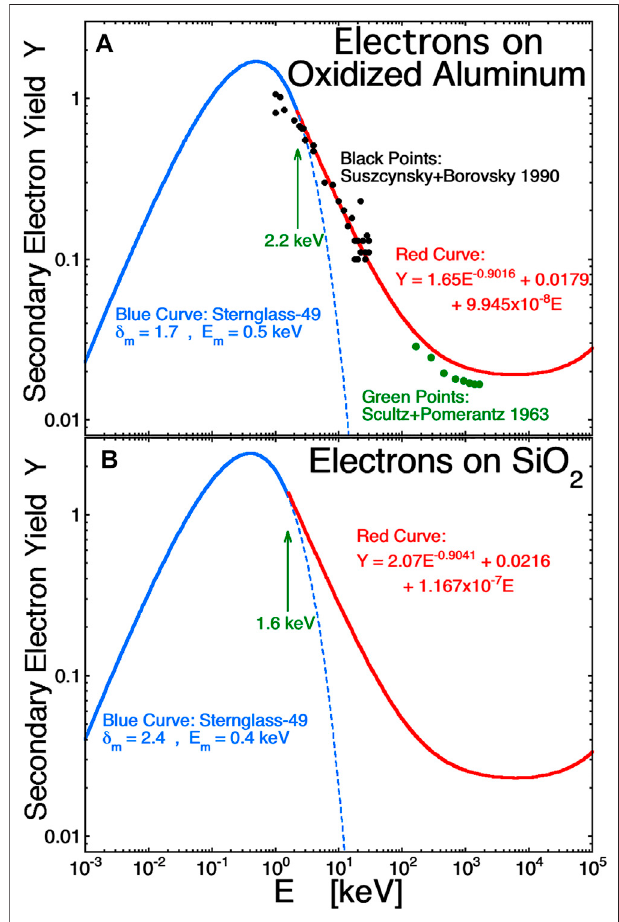
FIGURE 6 | Theoretical secondary-electron yield curves for relativistic electrons hitting (A) aluminum oxide and (B) SiO 2 .